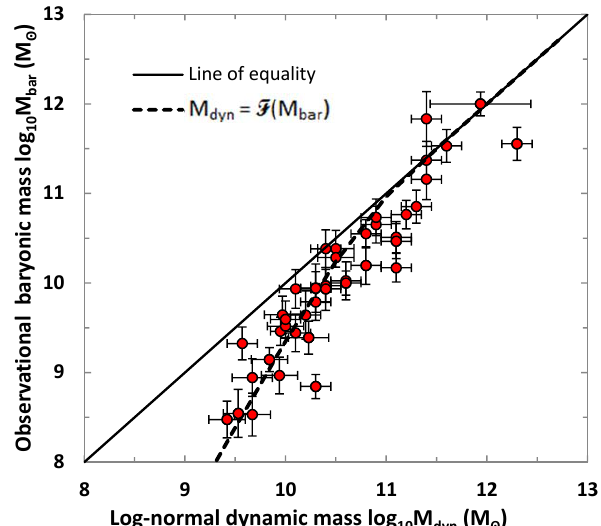
Figure 4. Log-log plot of the modelled lognormal dynamic disc mass vs. the estimated observational baryonic masses ( M g + M ∗ ) for a wide range of galaxy masses and types. The solid line is the line of mass equality; the dashed line is for M dynamic = f ( M baryonic ) , with M † = 3.98 × 10 10 M (cid:12) (see the